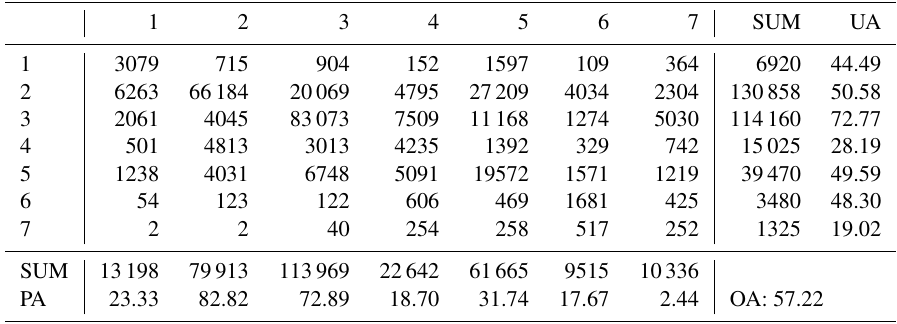
Table B4. Confusion matrix for LANDMATE PFT group 0.4 – the dominant LULC type occupies a minimum of 40% of a LANDMATE PFT grid cell.